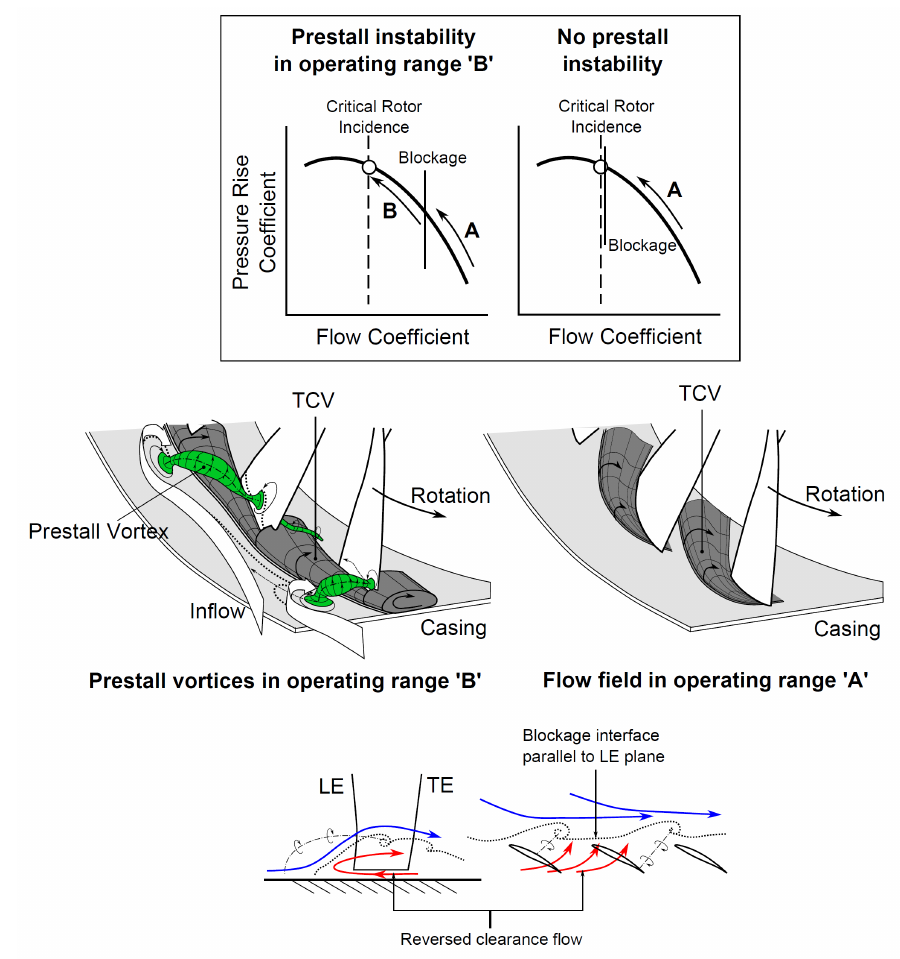
Figure 12. Model of prestall